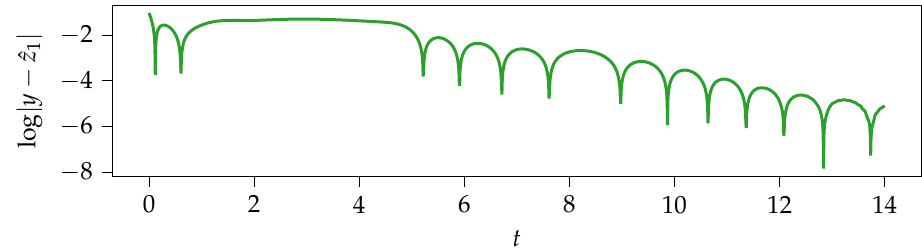
Figure 6. Observer error for the system (15) (logarithmic